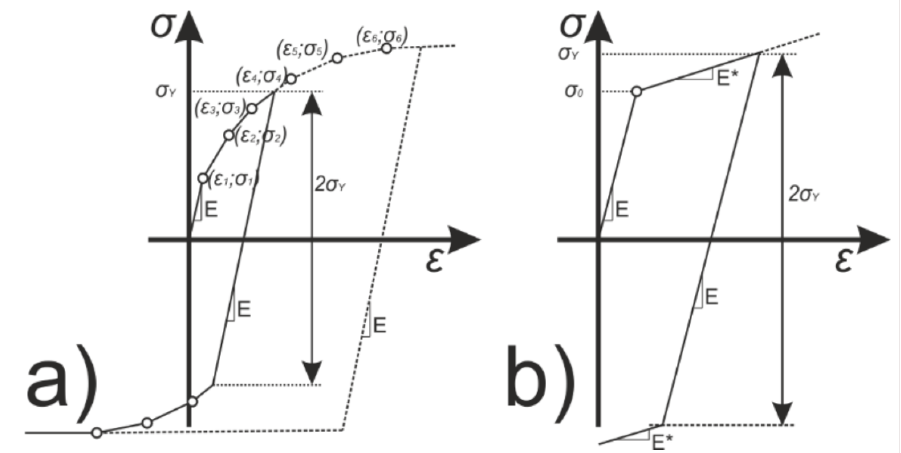
Figure 1. Stress vs. total strain for and multilinear ( a ) and bilinear ( b ) isotropic